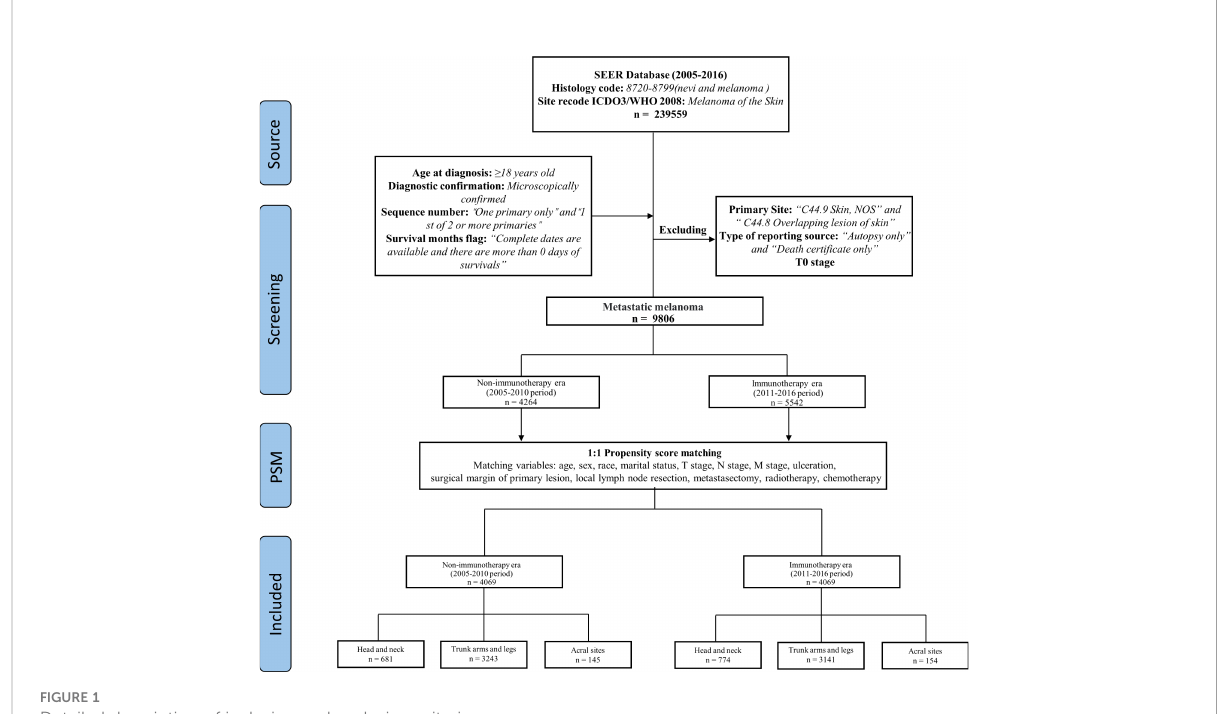
FIGURE 1 Detailed description of inclusion and exclusion criteria.